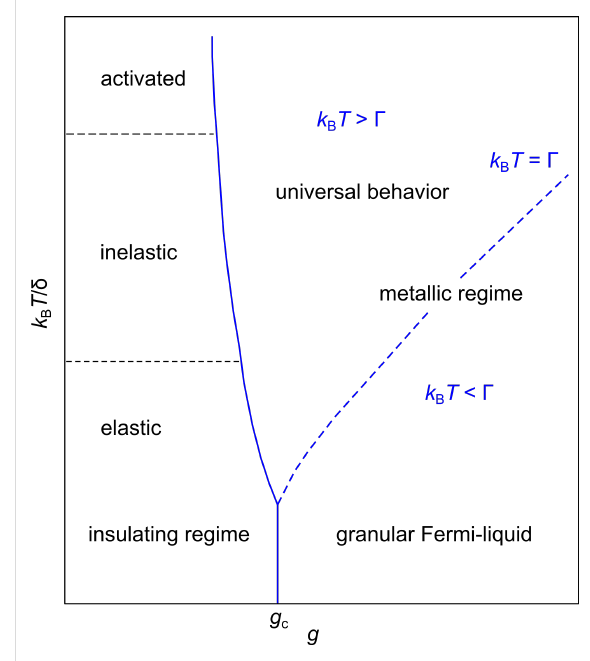
Figure 12: Phase diagram of the transport regimes of granular metals. In the insulating regime for g < g c thermally activated transport is observed of the Arrhenius type at elevated temperatures, which crosses over to correlated VRH due to inelastic or elastic cotunneling in the presence of potential disorder in the grains. In the metallic regime for g > g c a universal logarithmic correction for k B T > Γ is expected, which saturates at lower temperature as coherent transport develops (granular Fermi liquid). Adapted from